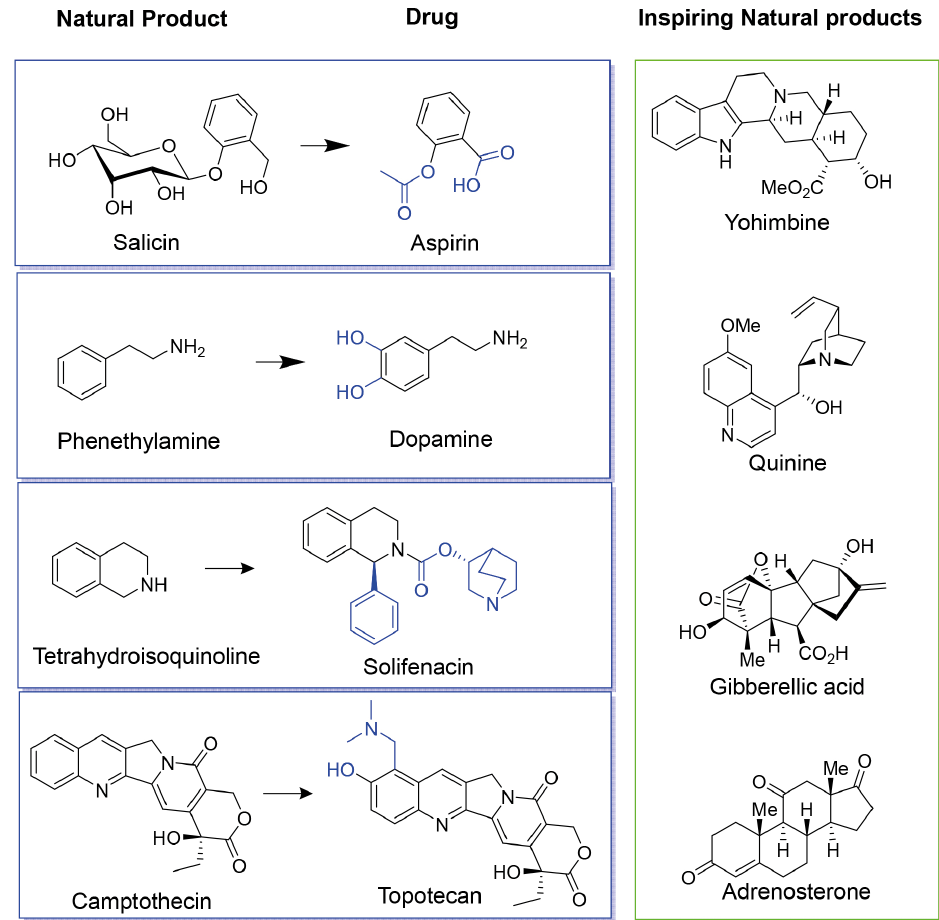
FIGURE 1 - Examples of natural products (NP) as sources of drugs (blue rectangle) and NP-inspiring compounds (green